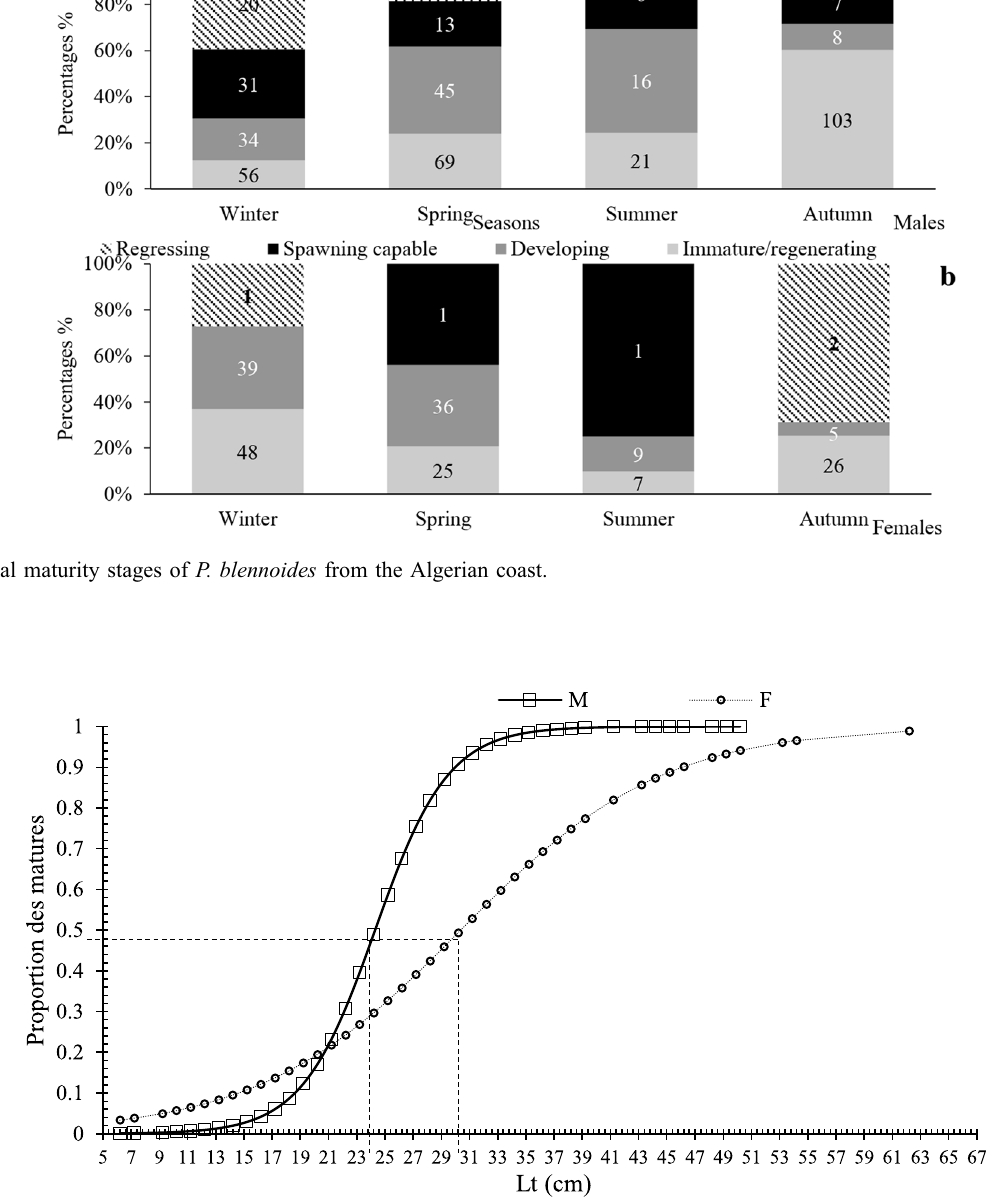
Fig. 10. Logistic regression model for the proportion of sexually mature males (M) and females (F) of P. blennoides (males L 50 = 24.30cm, females L 50 =